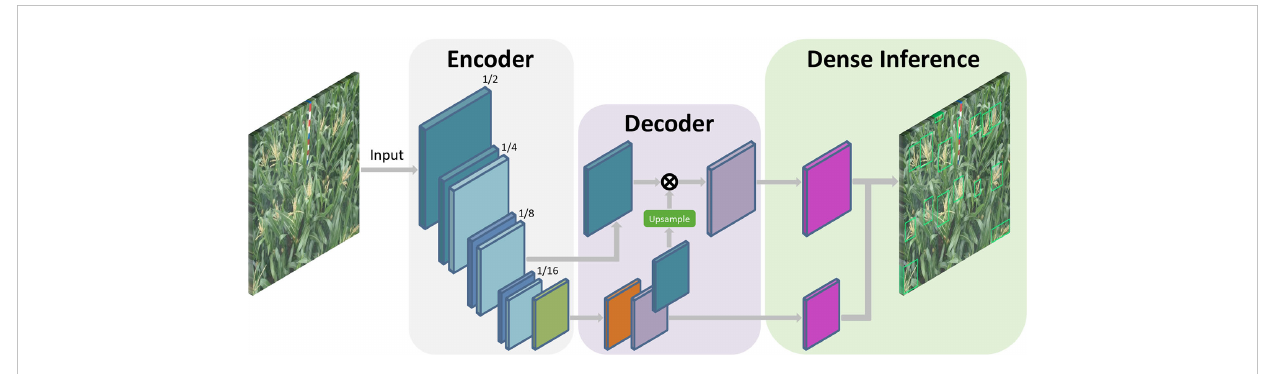
FIGURE 3 TasselLFANet global regression framework ( ⊗ indicates Concat